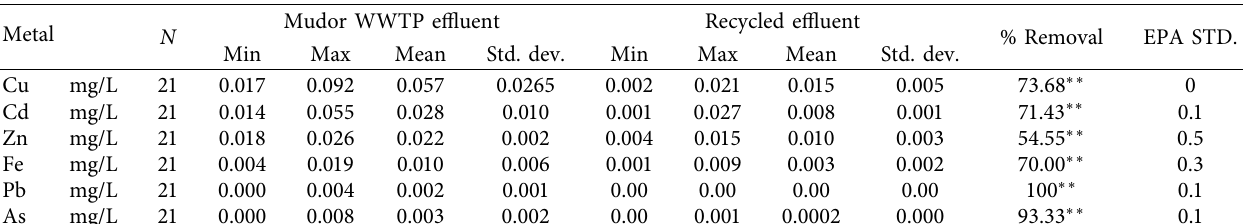
Table 4: Wk 2 mean results for analyzed heavy metal concentration of Mudor and lab-scale setup efuent.